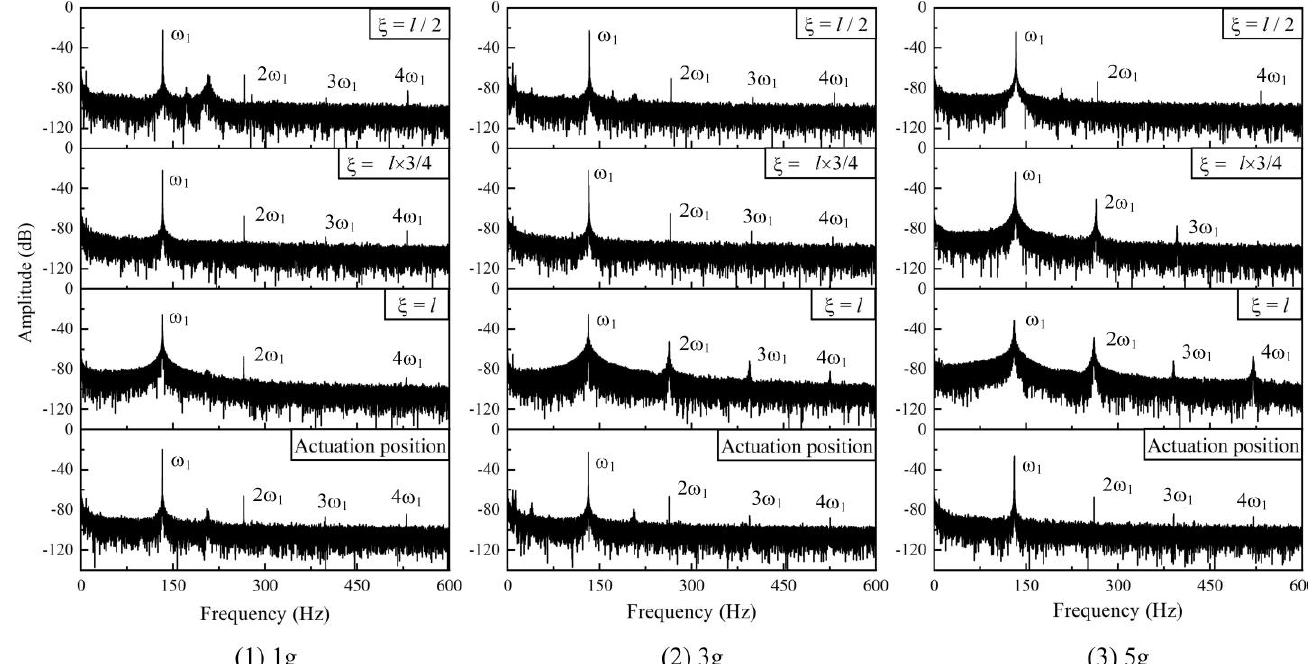
Figure 10. Vibration spectrogram of coupling system with symmetric additional mass.